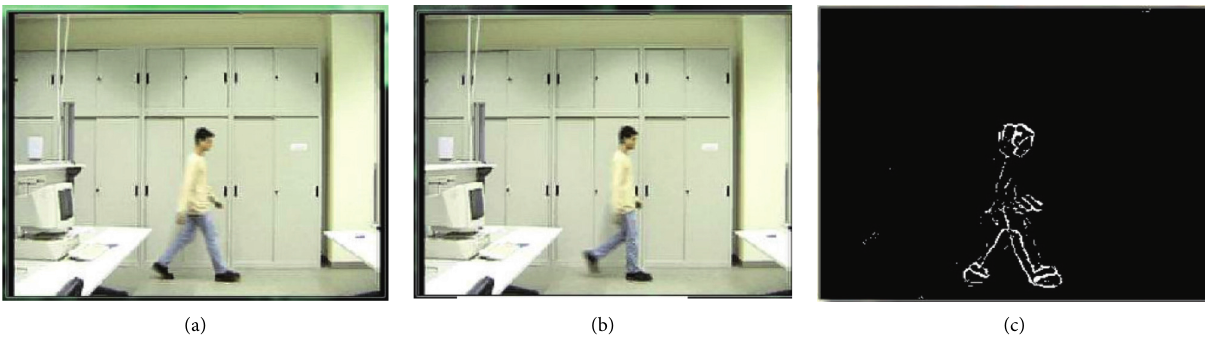
Figure 2: Experimental results of two-frames difference. (a) Frame 97. (b) Frame 98. (c) Two frames of differential images.